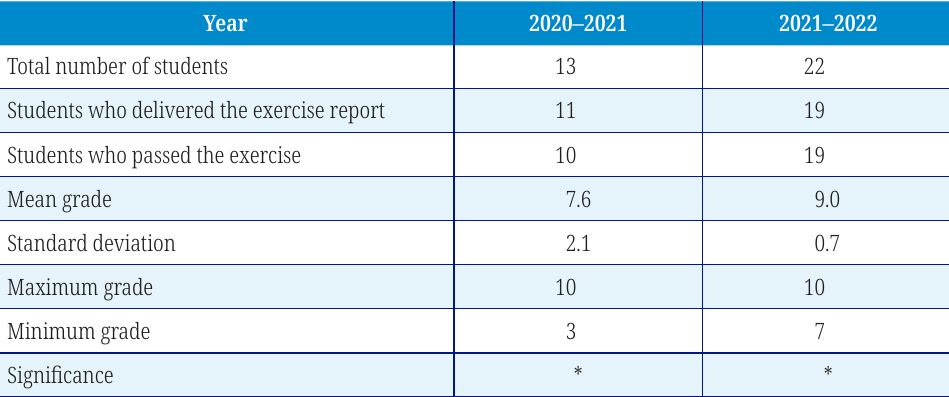
Table 5. Practical classroom activity about tractor stability in the Quality Systems and Work Safety course. Grades are indicated on a scale of 0 to 10